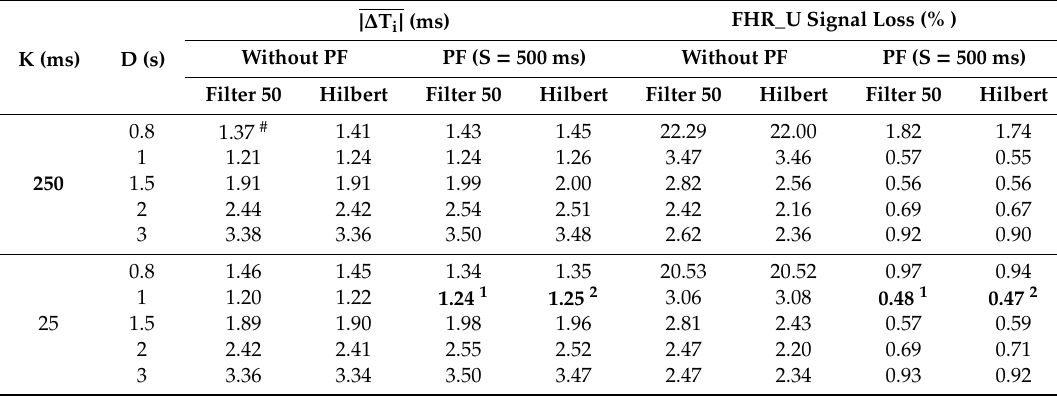
Table 3. Interval measurement errors and the FHR_U signal loss for di ff erent AF window widths D and various combinations of other control